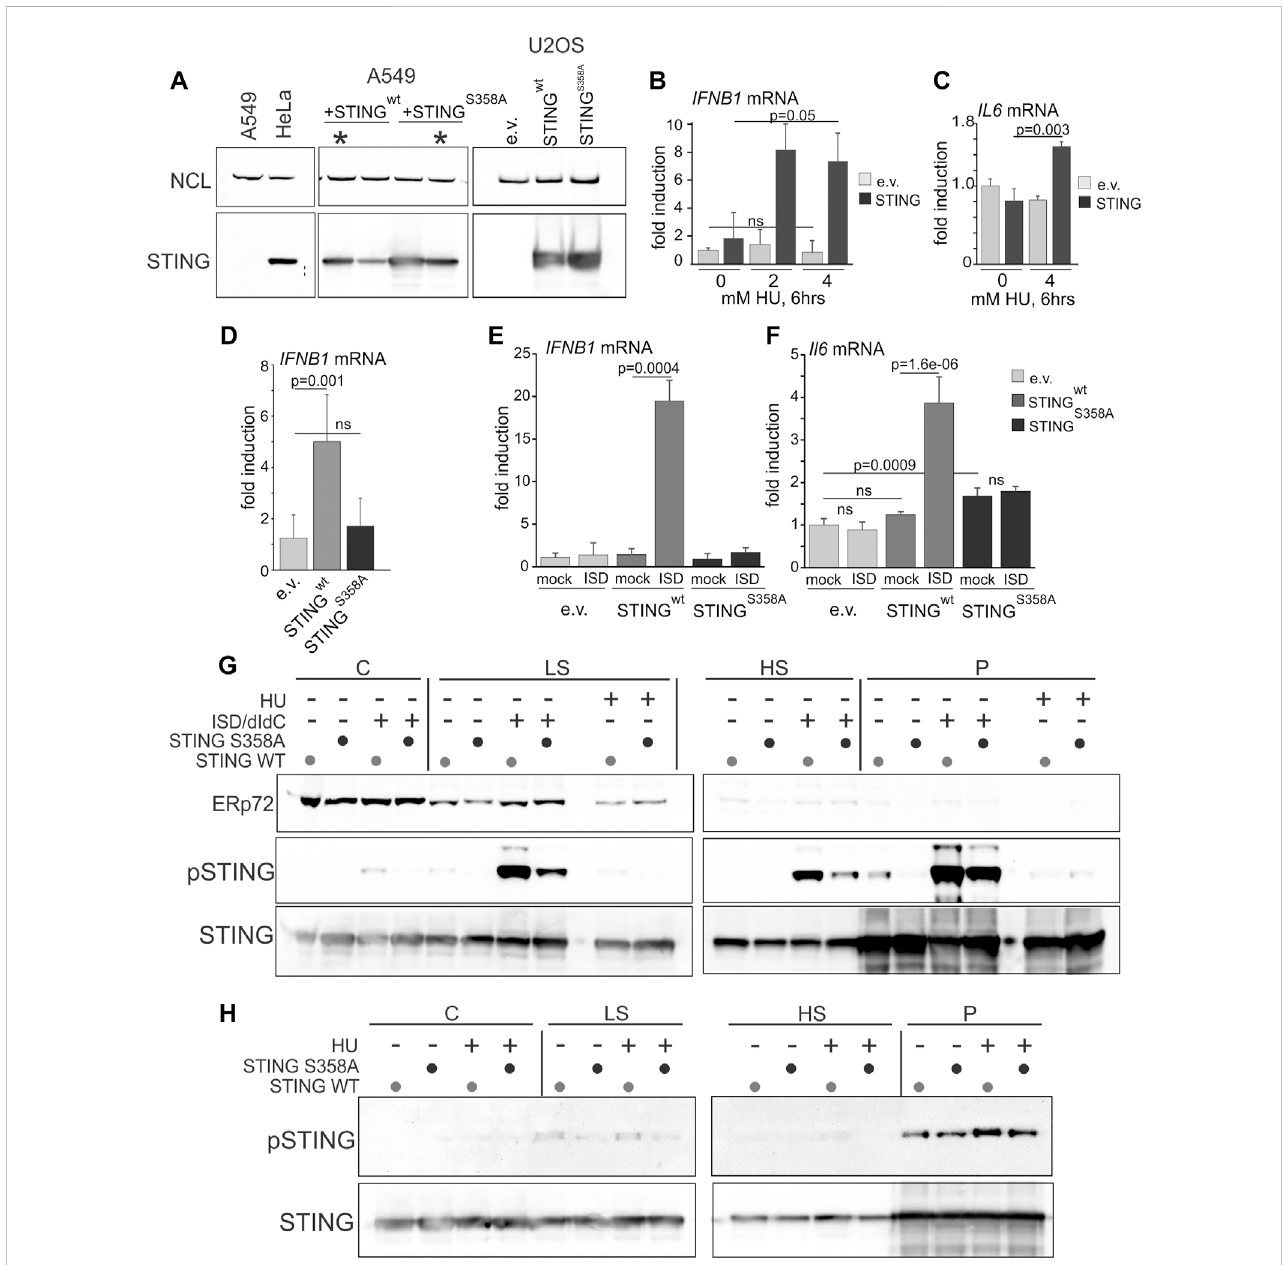
FIGURE 4 Serine 358 to alanine mutation of STING disrupts its ability to activate and induce downstream transcriptional targets in response to exogenous DNA or replication arrest by HU. (A) A Western blot of re-expression of wild type STING, or its S358A mutant in A549 and U2OS. Cells were stably transfected with empty lentiviral vector pTRIP-SFFV-mtagBFP-2A (e.v.) or with the same vector expressing variants of STING (pTRIP-SFFV-mtagBFP-2A STING). Cells were fl ow-sorted for BFP expression, and several fractionswere cultured and analyzed for STING expression to select populations with matching levels of the protein.ExamplesoftheA549selectionsaremarkedbyasterisks. (B) qPCRmeasurementsof IFNB1 mRNAinductioninU2OScellsexpressingSTINGorempty vector (e.v.) treated with 0, 2 or 4 mM HU for 6 h. (C) qPCR measurements of IL6 mRNA induction in U2OS cells expressing STING or empty vector (e.v.) treated with 0 or 4 mM HU for 6 h. (D) qPCR measurements of IFNB1 mRNA inductionin U2OS cells expressing the indicated STING variants or empty vector, incubated with 5 mM HU for 6 h. (E,F) qPCR measurements of IFNB1 (E) or IL6 (F) mRNA induction in U2OS cells expressing the indicated STING variants or empty vector, and mock-transfected or transfected with interferon-stimulating DNA (ISD). qPCR results represent two independent experiments each. Error barsthroughout arestandard deviations. p values werecalculated on ΔΔ Cq values in one-tailed two-sample t-tests. The colorkey[rightof (F) ]is common for (E,F) . (G) Western blots of the fractionated extracts of U2OS cells expressing STING WT or S358A. Cells were transfected with ISD/poly dI/dC mix or mock- transfected and incubated for 6 h prior to harvest. The HU-treated samples, included for comparison, were incubated with 5 mM HU for 6 h. Blots were probedforERp72,STINGS366P,andSTING. (H) WesternblotsofthefractionatedextractsofU2OScellsexpressingSTINGWTorS358AandprobedforSTING S366P and STING. Where indicated, HU treatment was for 5 h s at 5 mM. Note the higher exposure of STING S366P blots compared to those in (G) due to a lower S366P